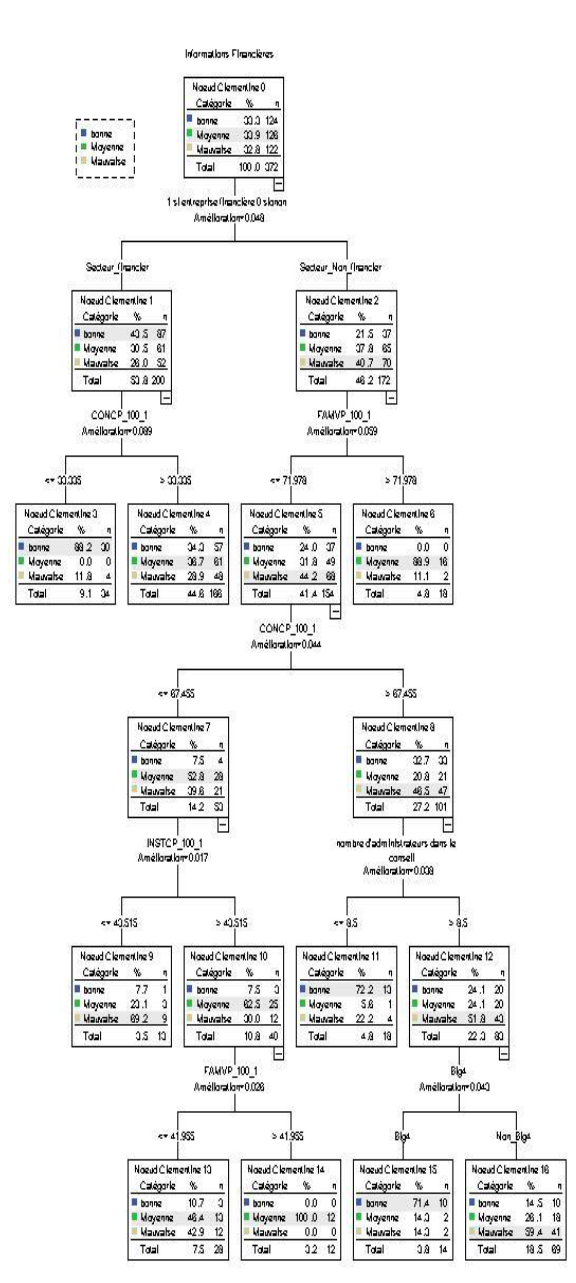
Figure IV – Decision Tree: Non Financial